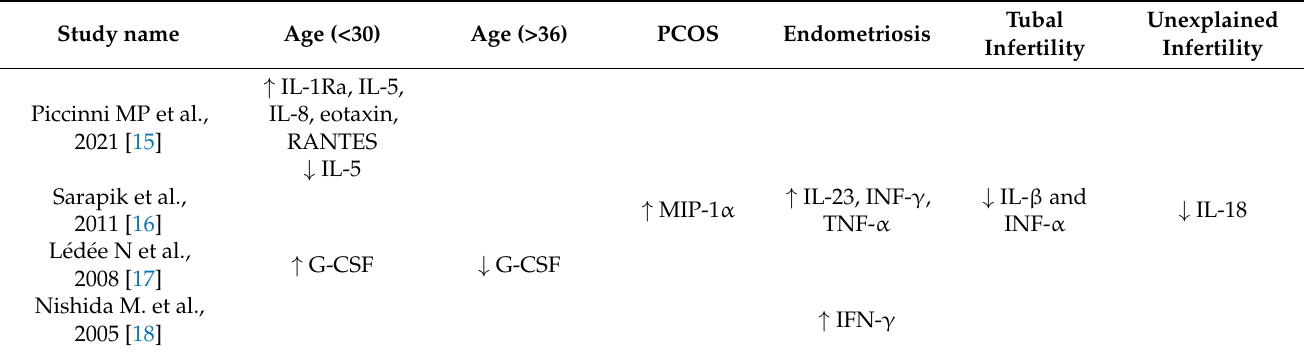
Table 1. Cytokines of the follicular fluid and their correlation with age of women and different reasons for